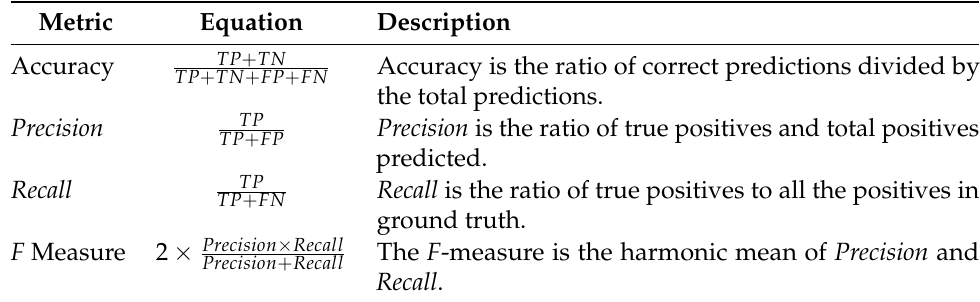
Table 1. Summarization of accuracy, recall, precision and F-measure. TP means true positives, TN true negatives, FP false positives and FN means false